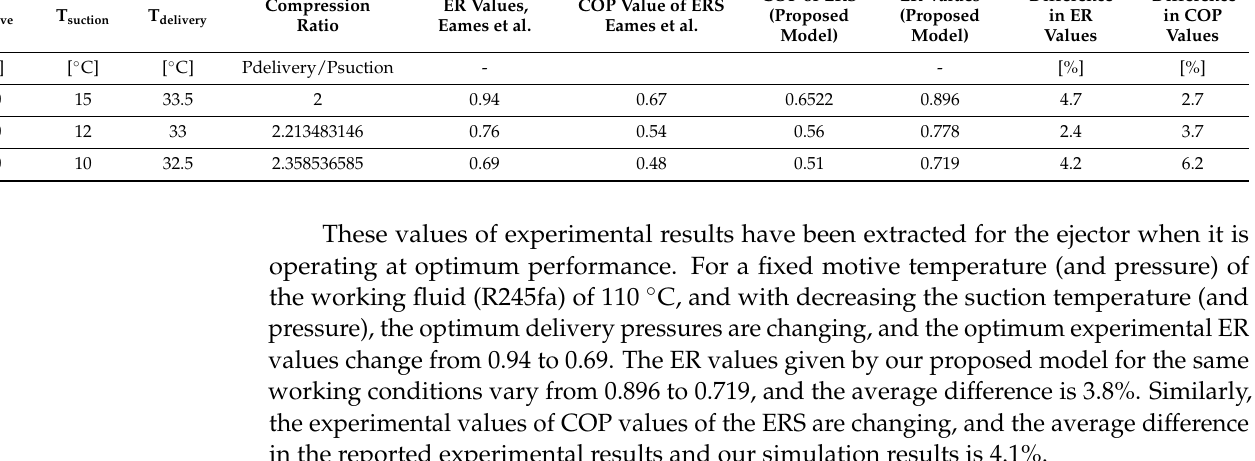
Table 2. comparison of Results of the proposed model with the experimental results reported by Eames et al. [32]. T motive T